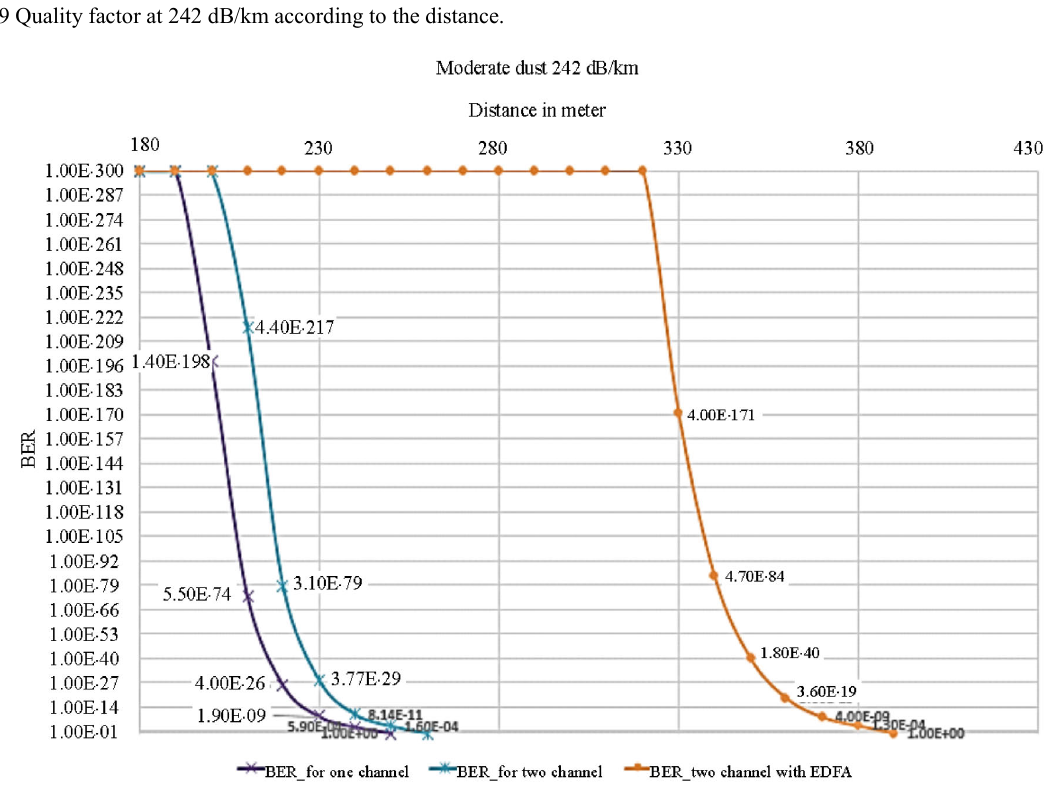
Fig. 10 BER performance comparison according to the distance at 242